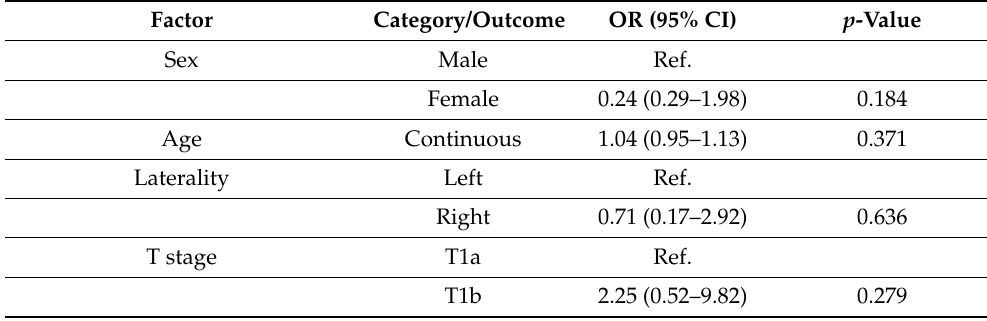
Table 9. Univariable analysis of prognostics factors for major post-operative